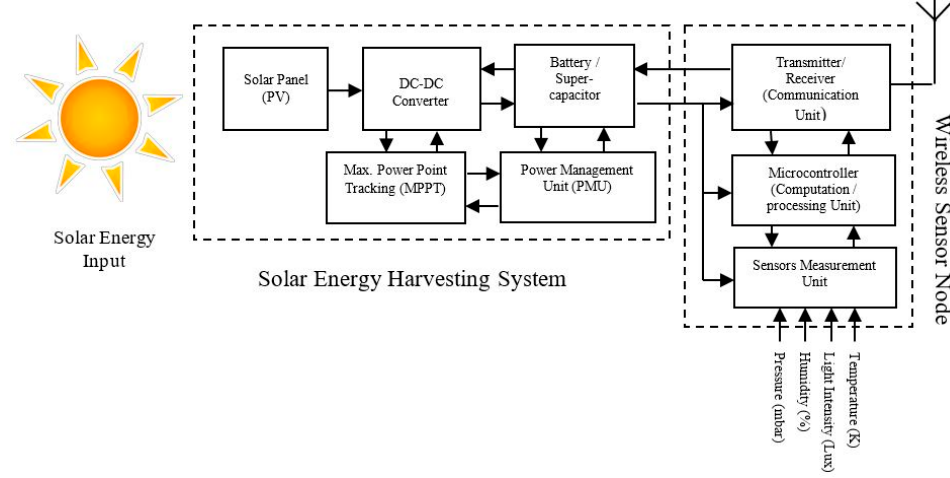
Figure 1. Block diagram of Solar Energy Harvesting Wireless Sensor Network Node (SEH-WSN).